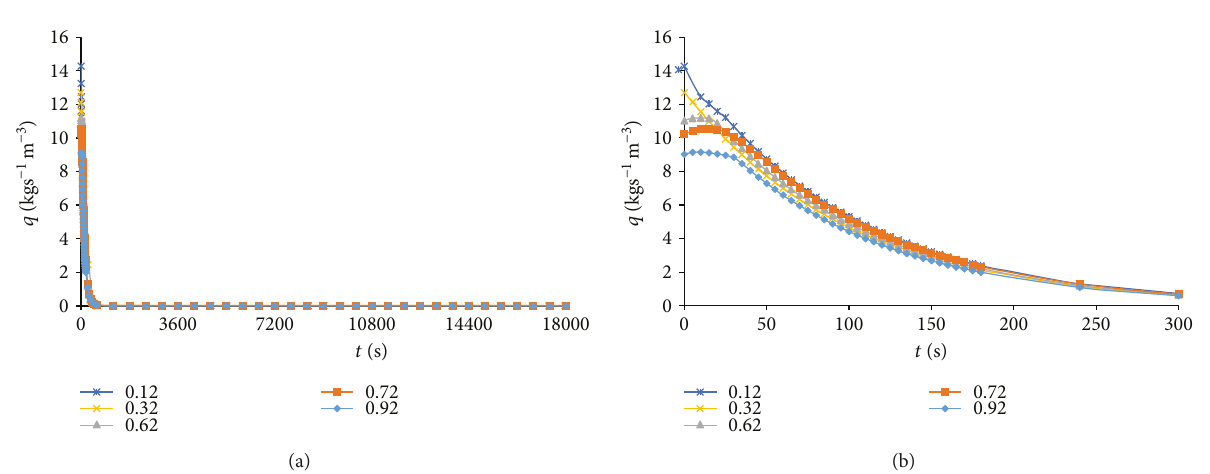
Figure 14: Time-varying curves of the mass-loss rate at di ff erent Talbol power